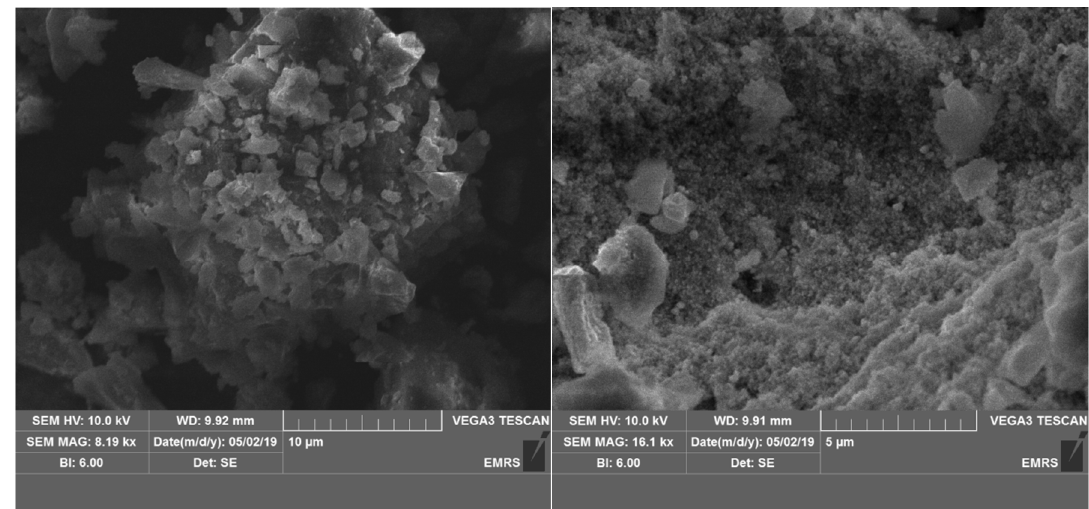
Figure 1. Low and high magnified SEM micrographs of Ag-CuO NC.